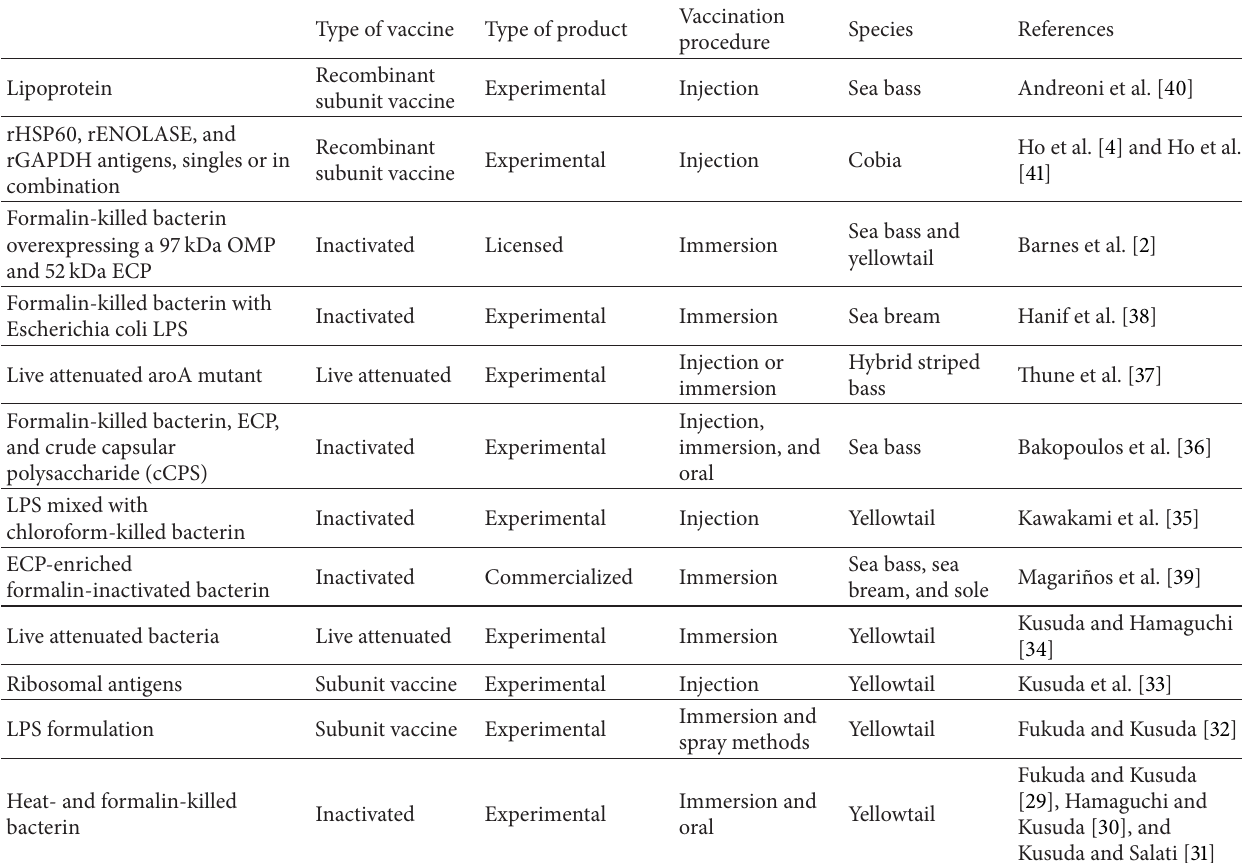
Table 1: Overview of vaccines against Photobacterium damselae subsp.